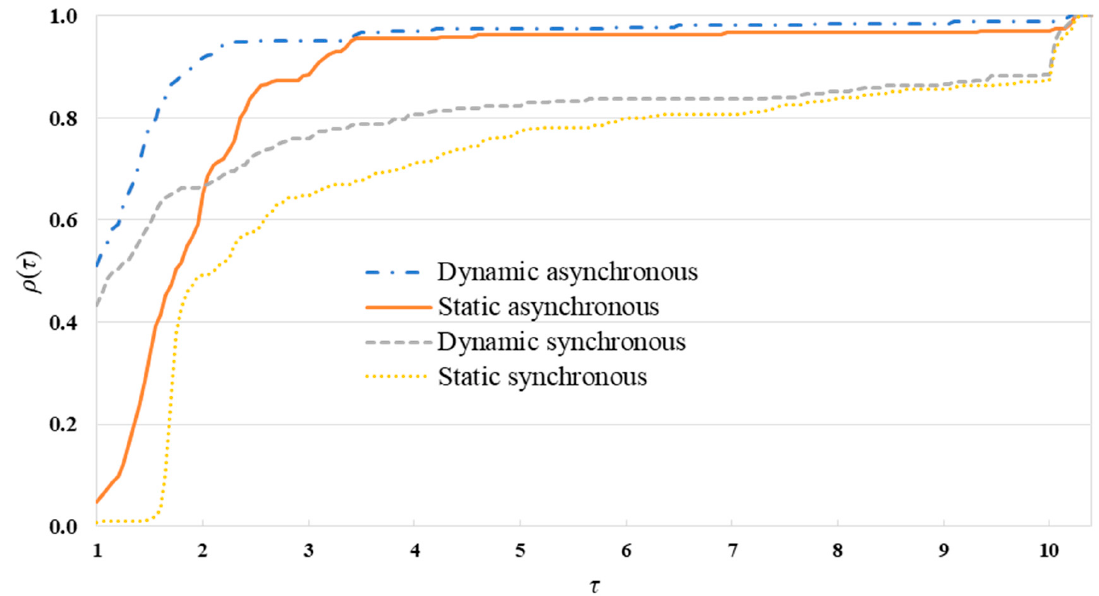
Figure 3. Performance profiles for the instances with machine Combination 2.